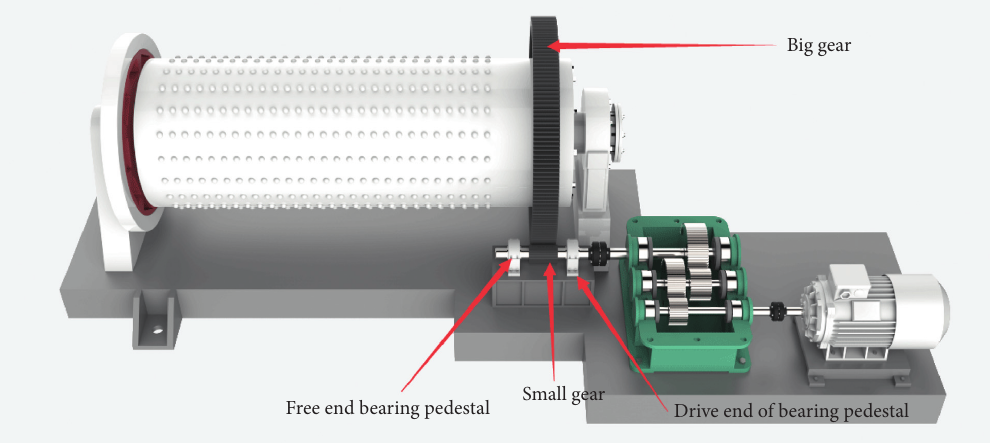
Figure 10: Structure of coal mill.